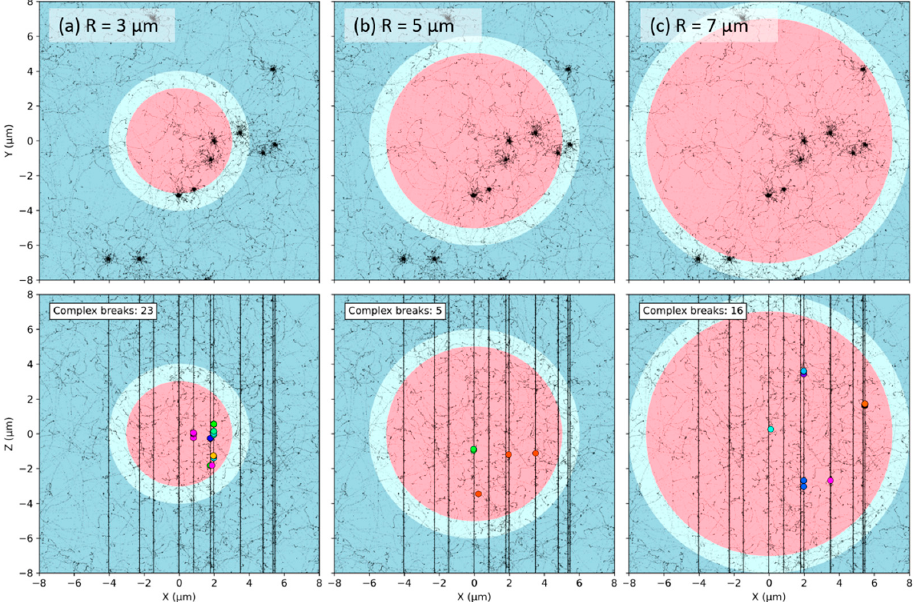
Figure 11. Projected track structure (black dots and lines) and complex DSBs (colored circles) before repair for a Si 170 MeV/n Si irradiation (LET 99 keV/ μ m) and dose of 0.5 Gy. Views are shown from atop (top) and side (bottom). The disks represent the cell nucleus (pink) and cytoplasm (cyan), embedded in water (blue). Results are shown for three nuclear radii (( a ) 3 μ m, ( b ) 5 μ m, and ( c ) 7 μ m) and without chromosome domain constraint. The different colors of the DSBs represent distinct chromosomes.